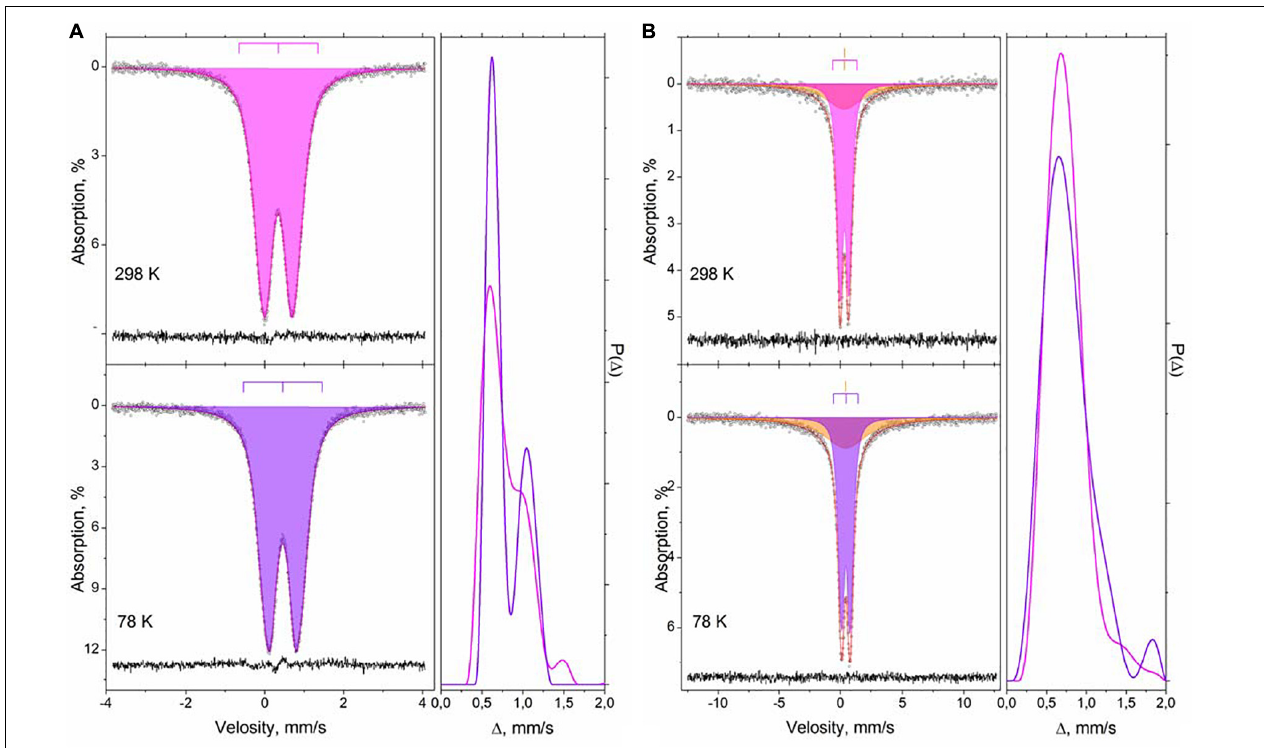
FIGURE 5 | Mössbauer spectra of the M and S samples ( A,B , respectively) recorded at 295K and 78K and the quadrupole splitting distributions for these spectra.